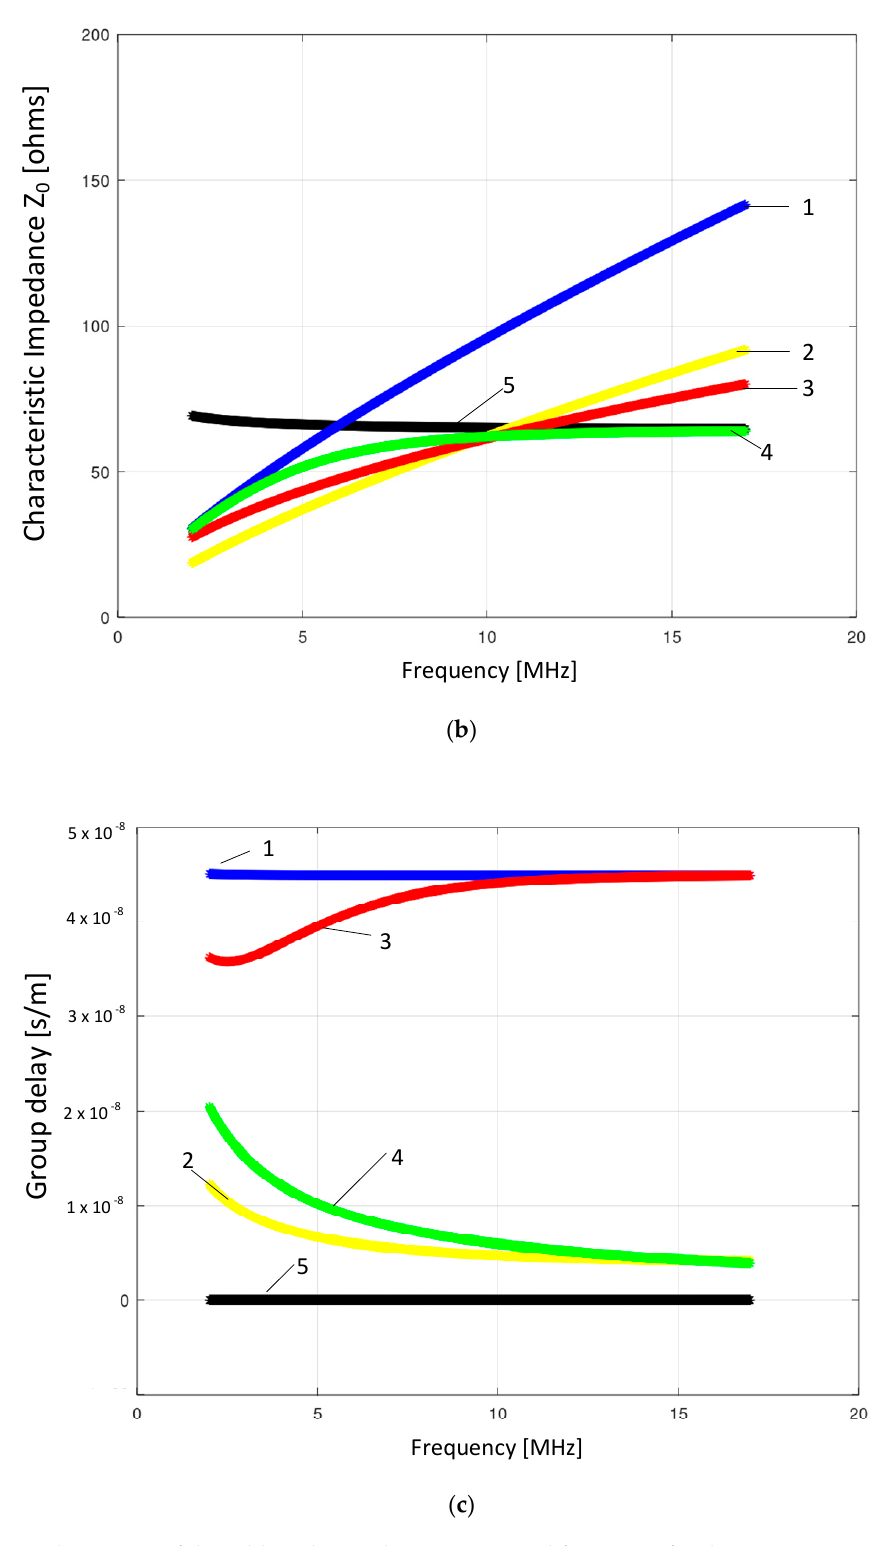
Figure 5. The impact of the cable’s electrical parameters and frequency for the capacitive-inductive coupling: ( a ) Comparison of calculated values of attenuation factor α as a function of cable length in 5 analyzed approaches; ( b ) Calculated characteristic impedance Z 0 of the analyzed cable as a function of frequency in 5 analyzed approaches; ( c ) Calculated group delay versus frequency in 5 analyzed approaches.